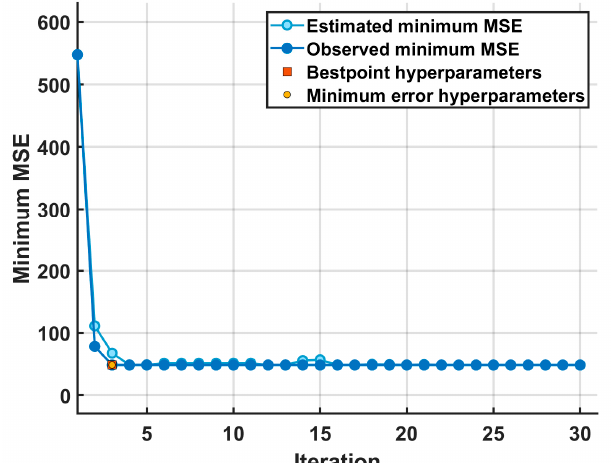
Figure 3. MSE optimization plot of the ANN model.